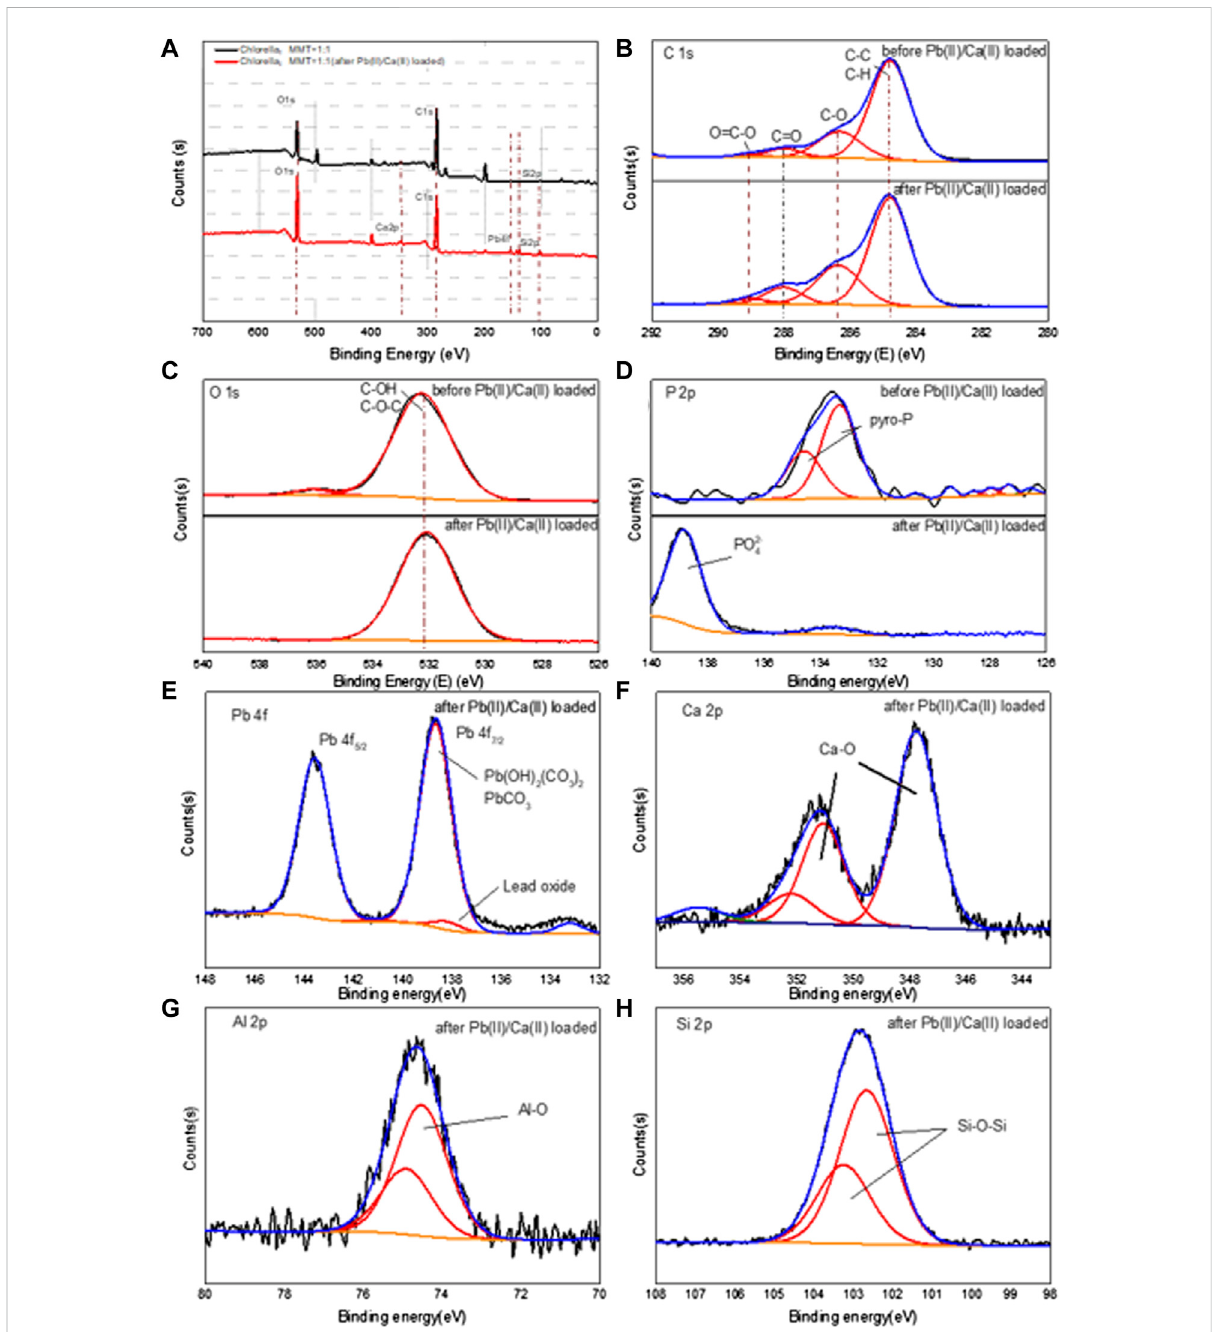
FIGURE 8 XPSspectraoffullspectrum (A) ,Cls (B) ,O1s (C) ,andP2p (D) beforeandafterPb(II)/Ca(II)loaded;Pb4f (E) ,Ca2p (F) ,Al2p (G) ,andSi2p (H) after Pb(II)/Ca(II) loaded on Chlorella – MMT (1:1)